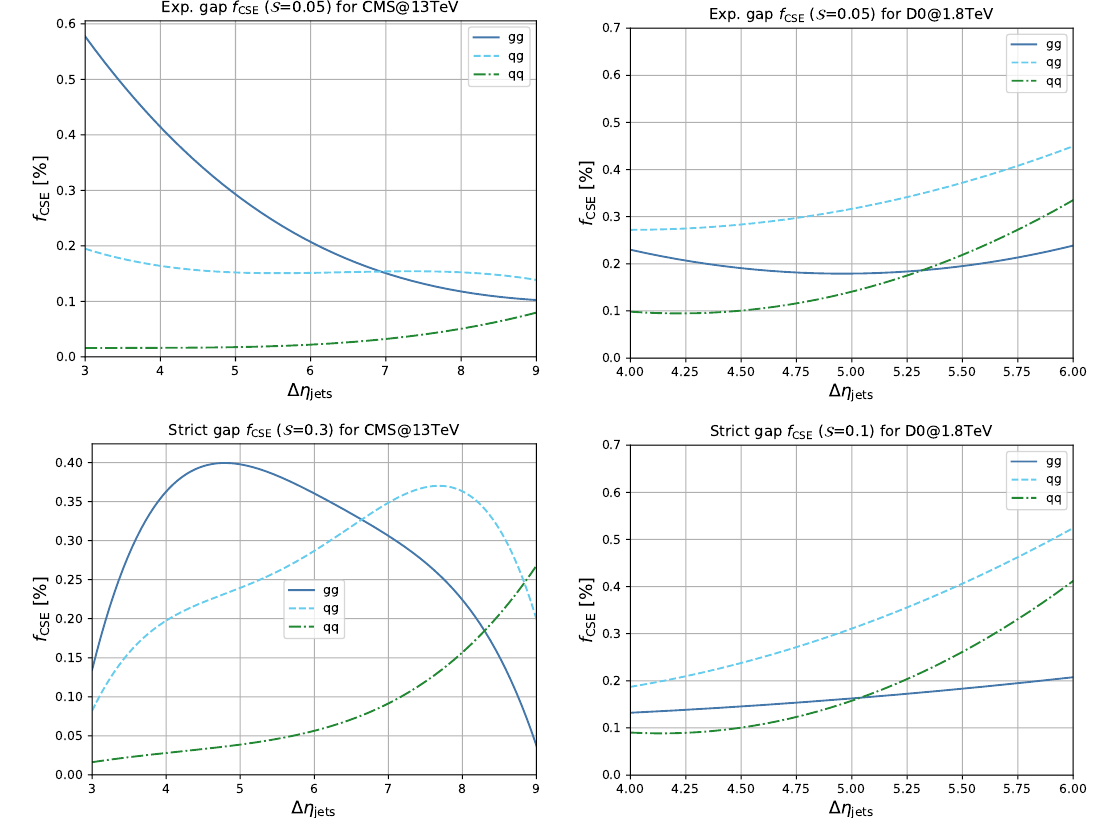
Figure 10 . Fraction f CSE separated by the underlying qq → qq , gg → gg , qg → qg contributions to the CSE process. The two upper panels correspond to the experimental gap predictions, whereas the two lower panels correspond to the strict gap definition. The left panels correspond to the CMS 13 TeV cuts, whereas the right panels correspond to the D0 1.8 TeV